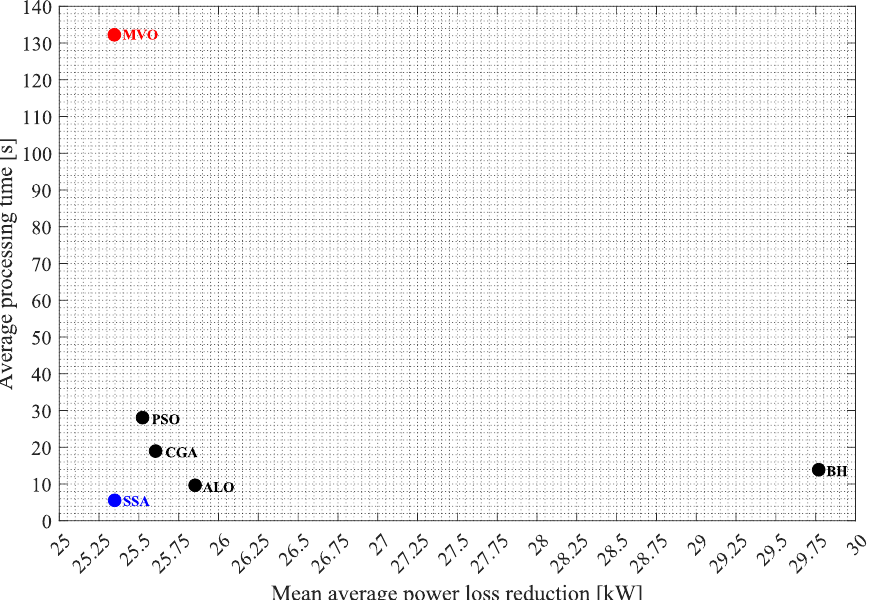
Figure 12. Trade-off provided by the solution methodologies between mean average power losses and required processing time in the 69-node